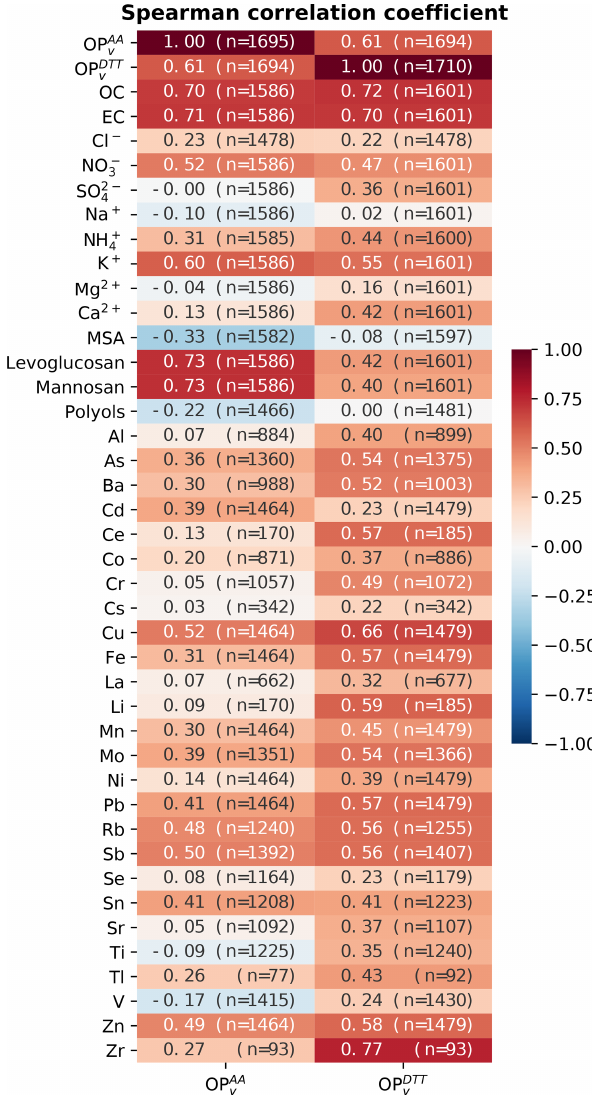
Figure A1. Spearman correlation coefficients between OP AA v and OP DTT v and the chemical species observed at each site. The numbers of samples are specified in